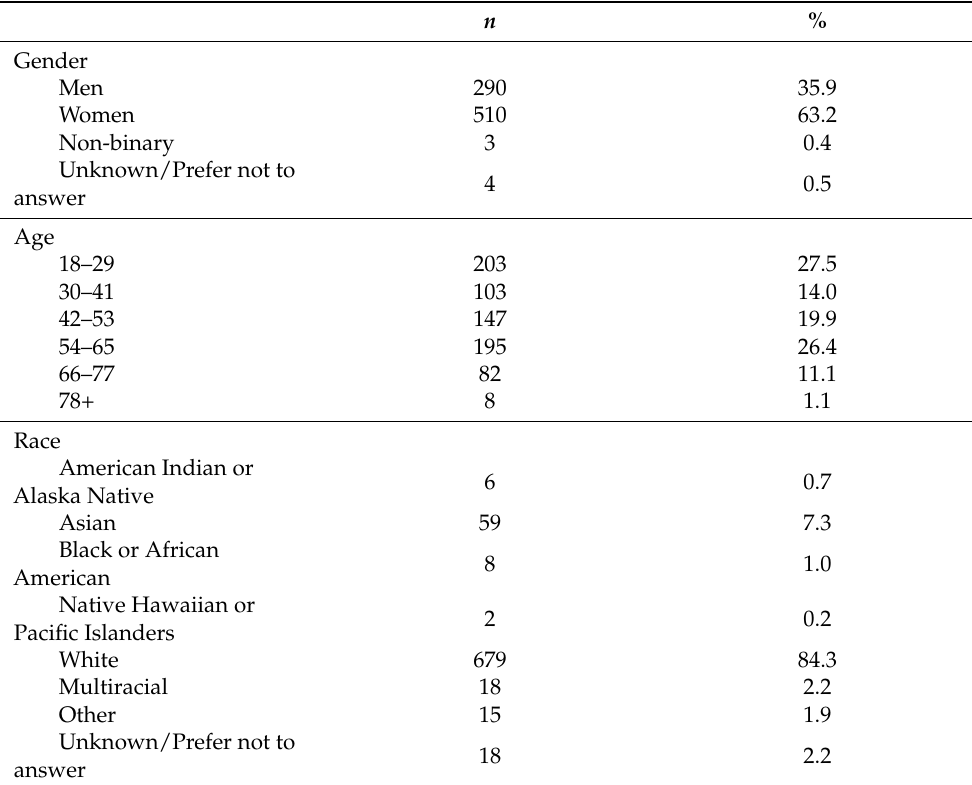
Table 1. Characteristics of survey respondents ( n = 808) a